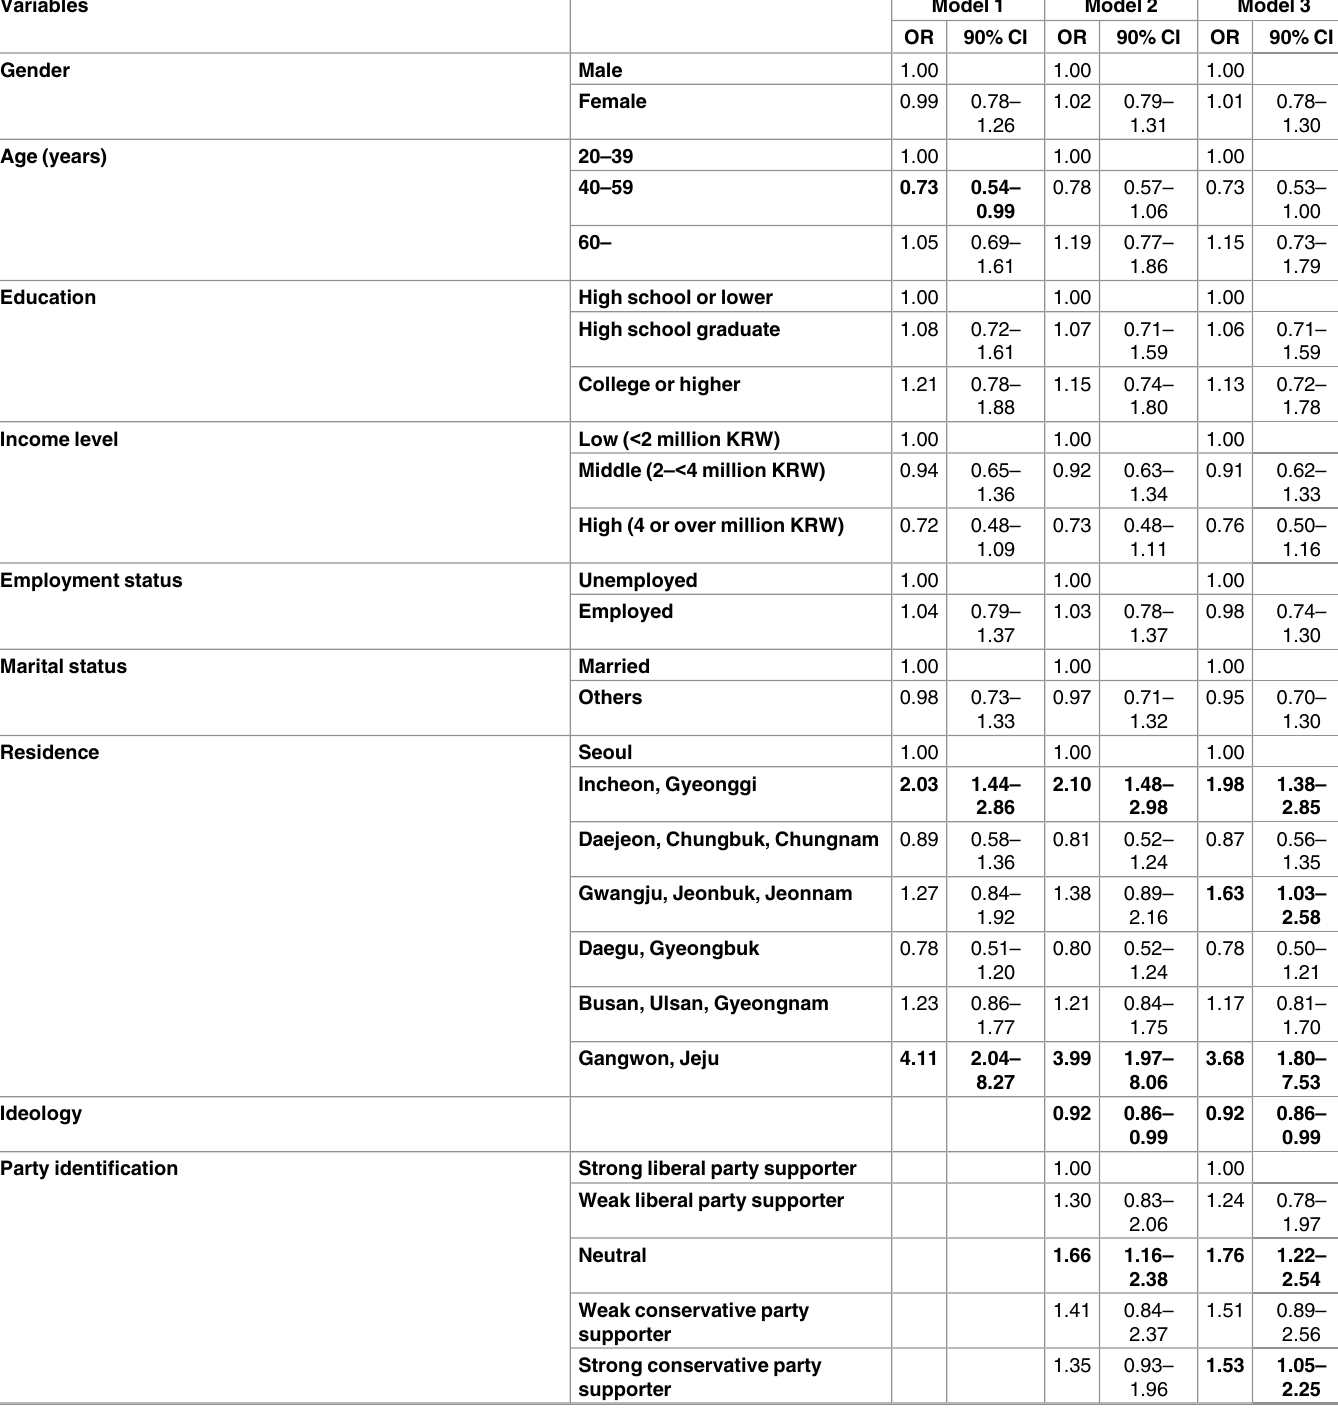
Table 2. Factors Affecting Attitudes towards Increasing Public Expenditure on